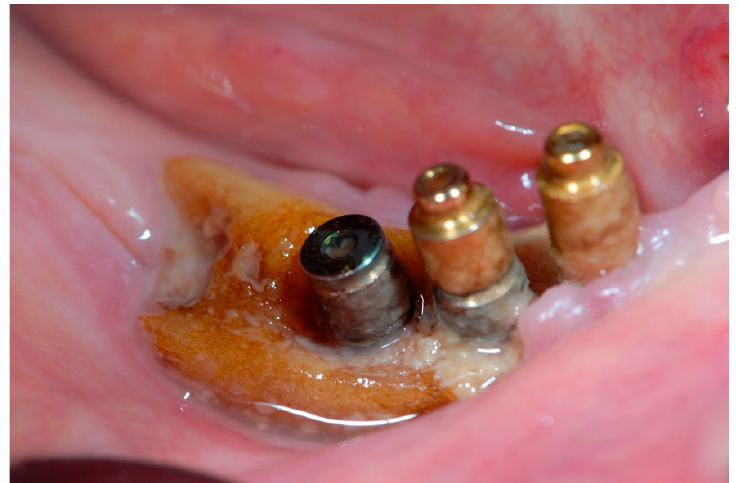
Figure 2. Clinical aspect of a patient affected by grade 3 MRONJ who received “palliative” PBM application over a large bone exposition around the implants.